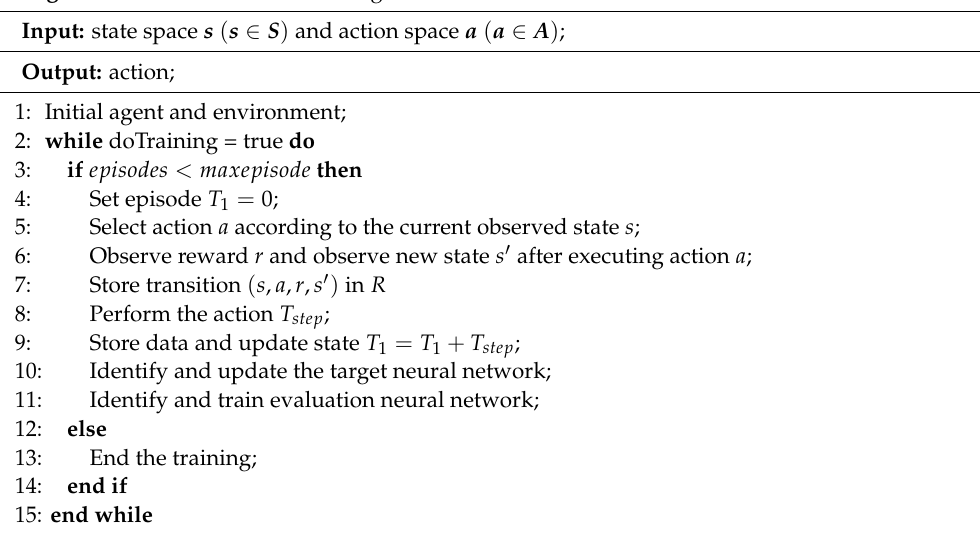
Algorithm 1 The DDPG Control